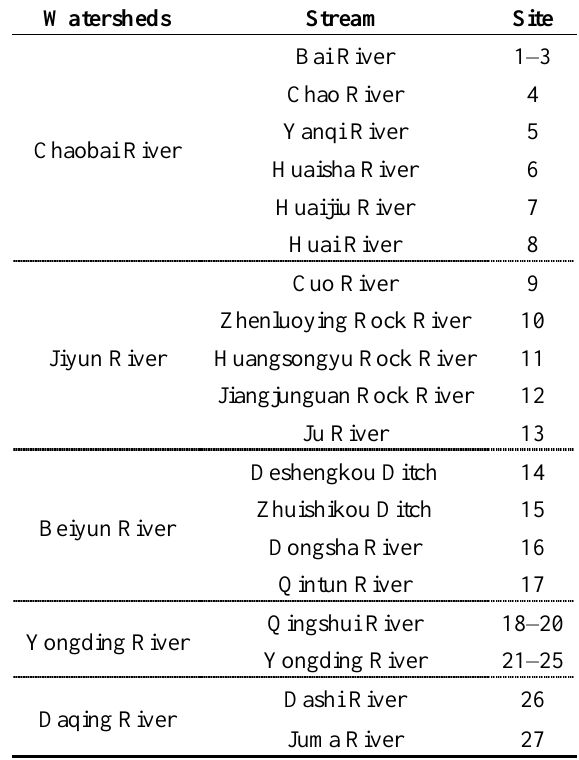
Table 1. The streams and watersheds of the 27 monitoring sites.